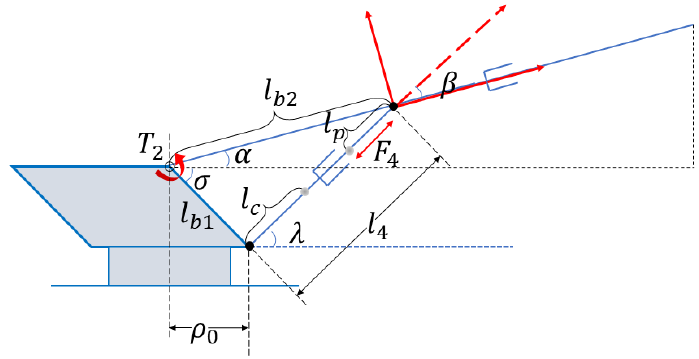
Figure 4. Dimensions of the transfer gangway and frames of the telescopic